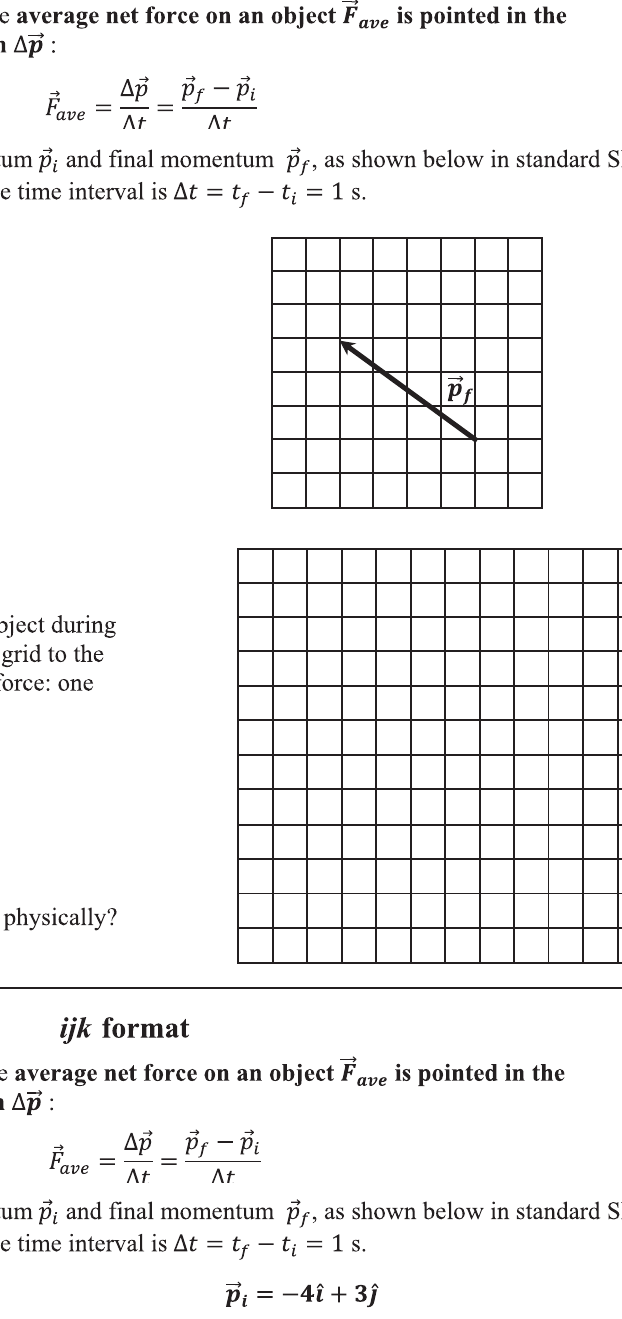
FIG. 13. Change in momentum physics context questions in arrow and ijk